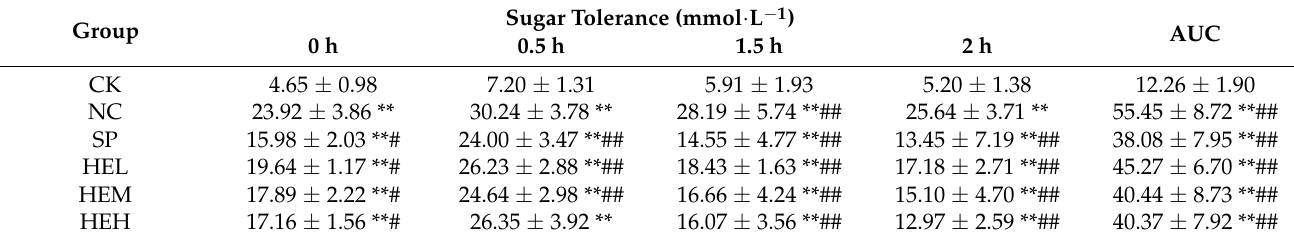
Table 7. Glucose tolerance changes of mice in the different treatment groups.